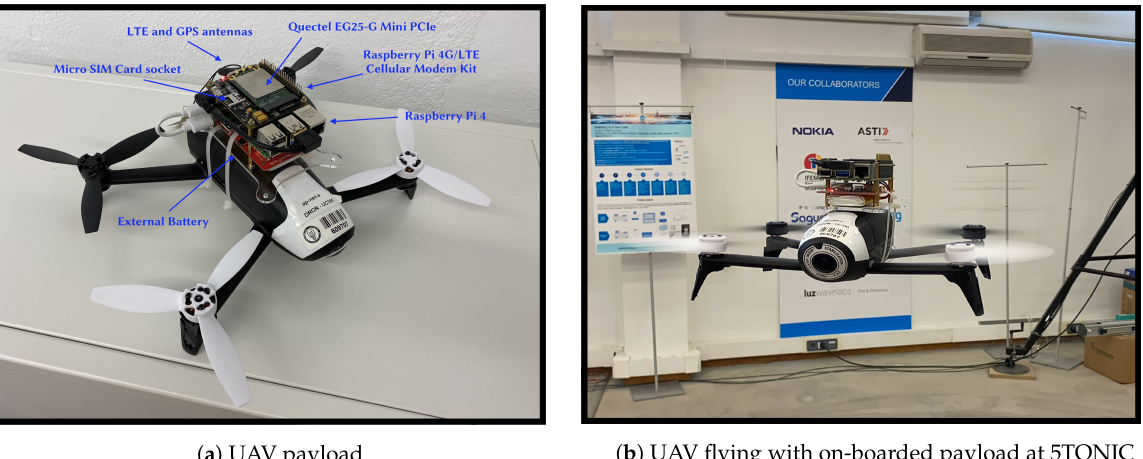
Figure 3. Details of UAV payload, and UAVs in